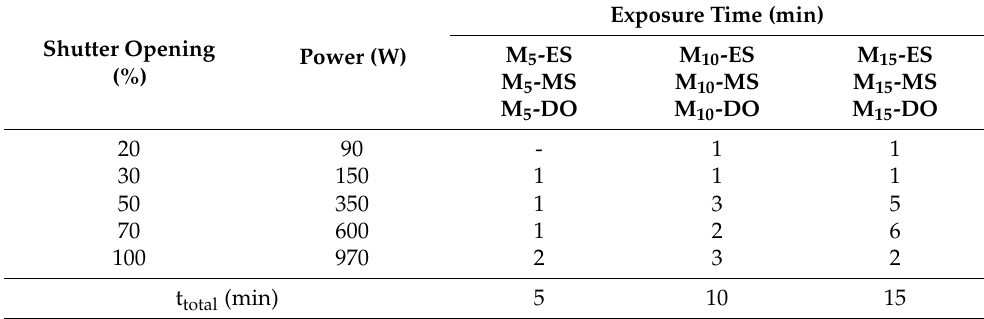
Table 1. Experimental conditions for the exposure of samples to concentrated solar